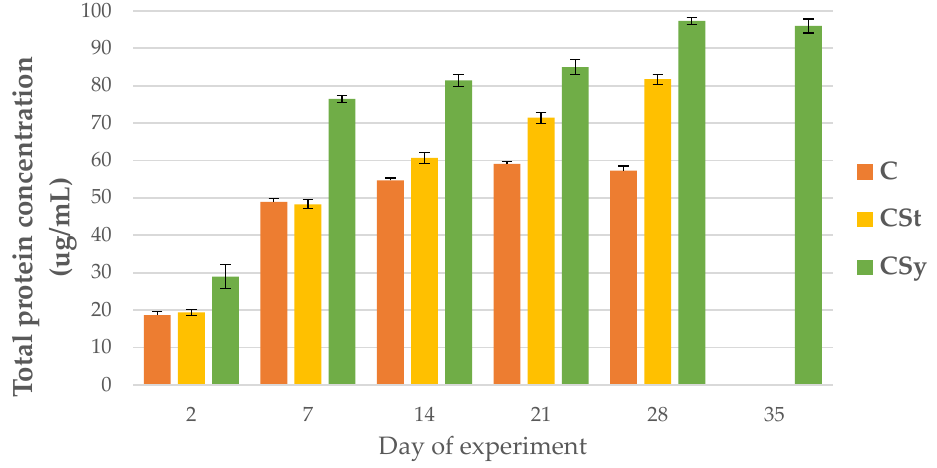
Figure 1. Total protein concentration in the 2, 7, 14, 21, 28, 35-day-old workers’ hemolymph after two methods of supplementation with hemp extract: C-control (pure sugar syrup), CSy-hemp extract in syrup, CSt-hemp extract on strips. Two-Way ANOVA: supplementation method F (2, 156) = 31,397; p = 0.0000, se ± 2.931476–2.649163; days of supplementation: F (4, 143) = 6677.0, p = 0.0000, se ± 0.268945–0.465826; supplementation method × days of supplementation F (8, 143) = 203.83, p = 0.0000, se ±